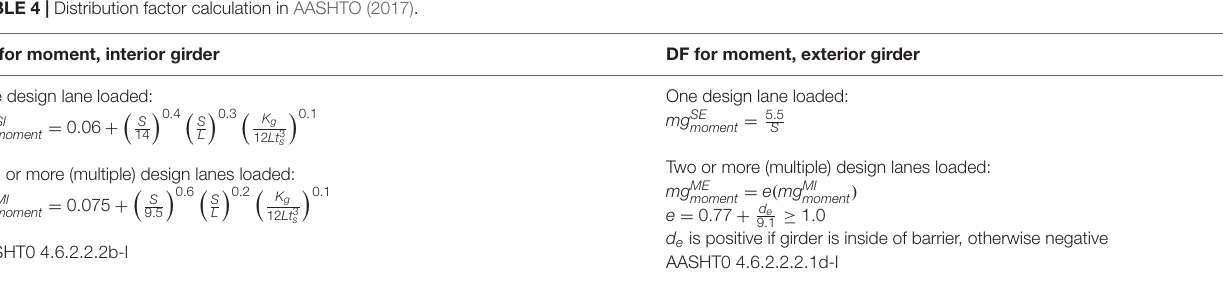
TABLE 4 | Distribution factor calculation in AASHTO